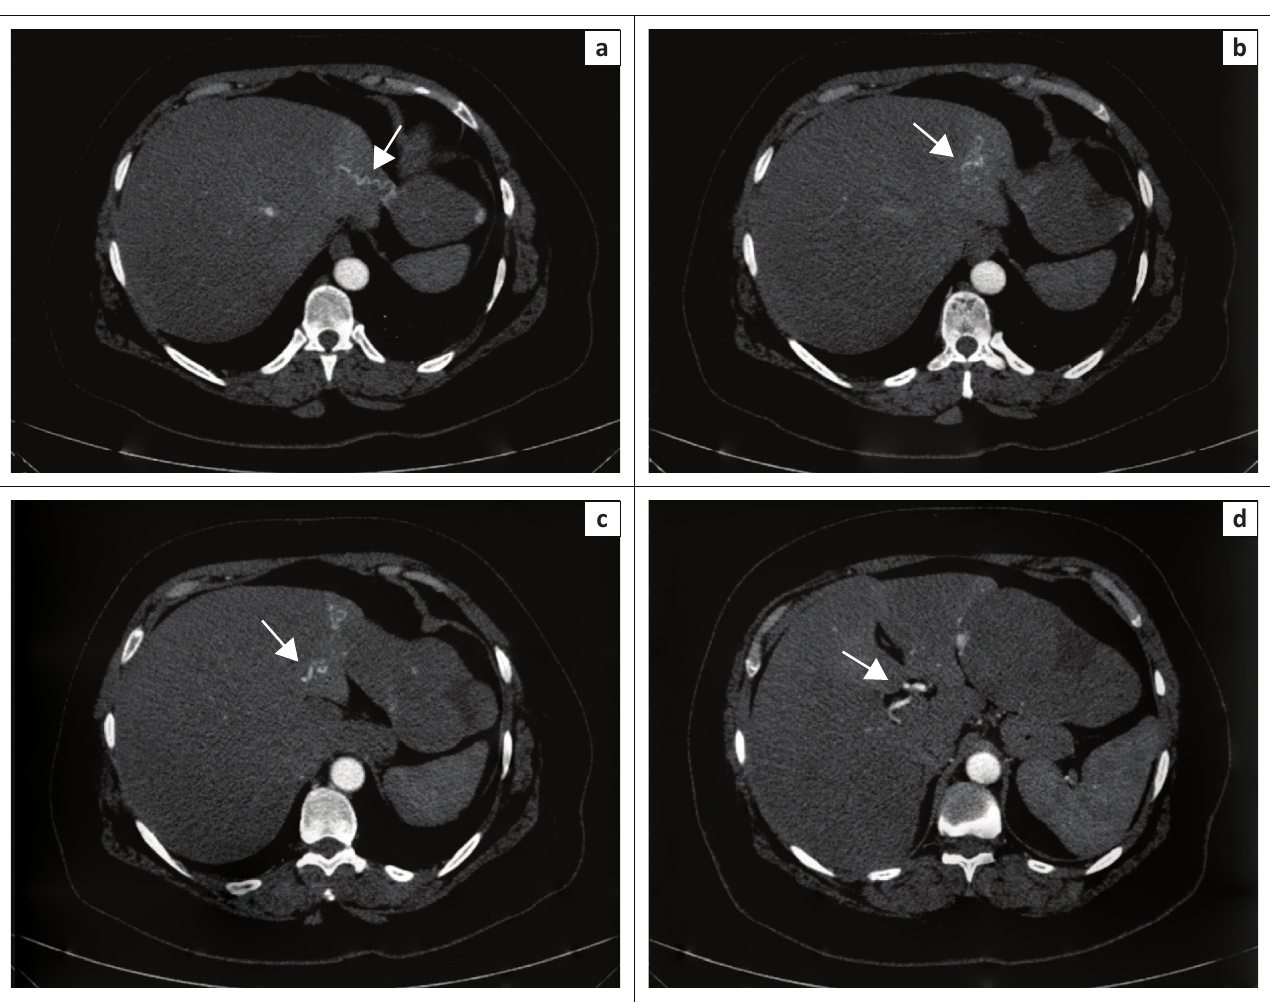
FIGURE 3: Arterial phase thin section reconstructions of the upper part of the mass (a) and (b) show a tortuous vessel with arterial flow within (arrow) passing from the left lobe of the liver into the mass through a thin sliver of tissue (pedicle). The adjoining part of the liver parenchyma also shows abnormal enhancement in the arterial phase. The vessel can be traced back to the left branch of the hepatic artery in successive images (c) and (d)